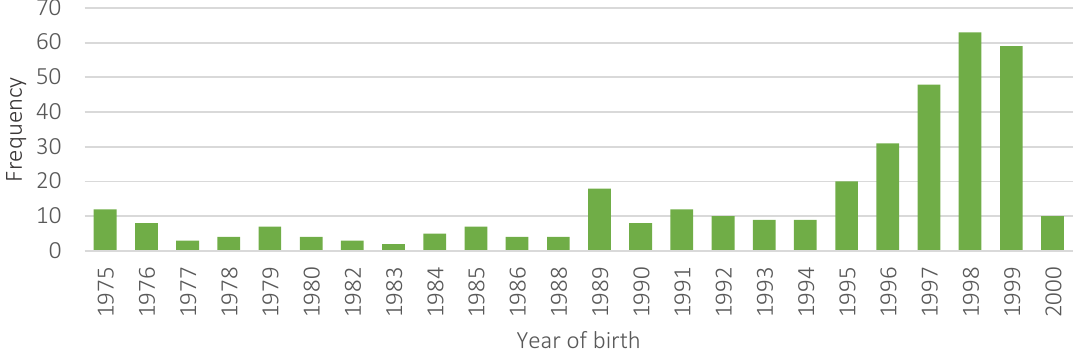
Figure 1. Distribution of age of the examined